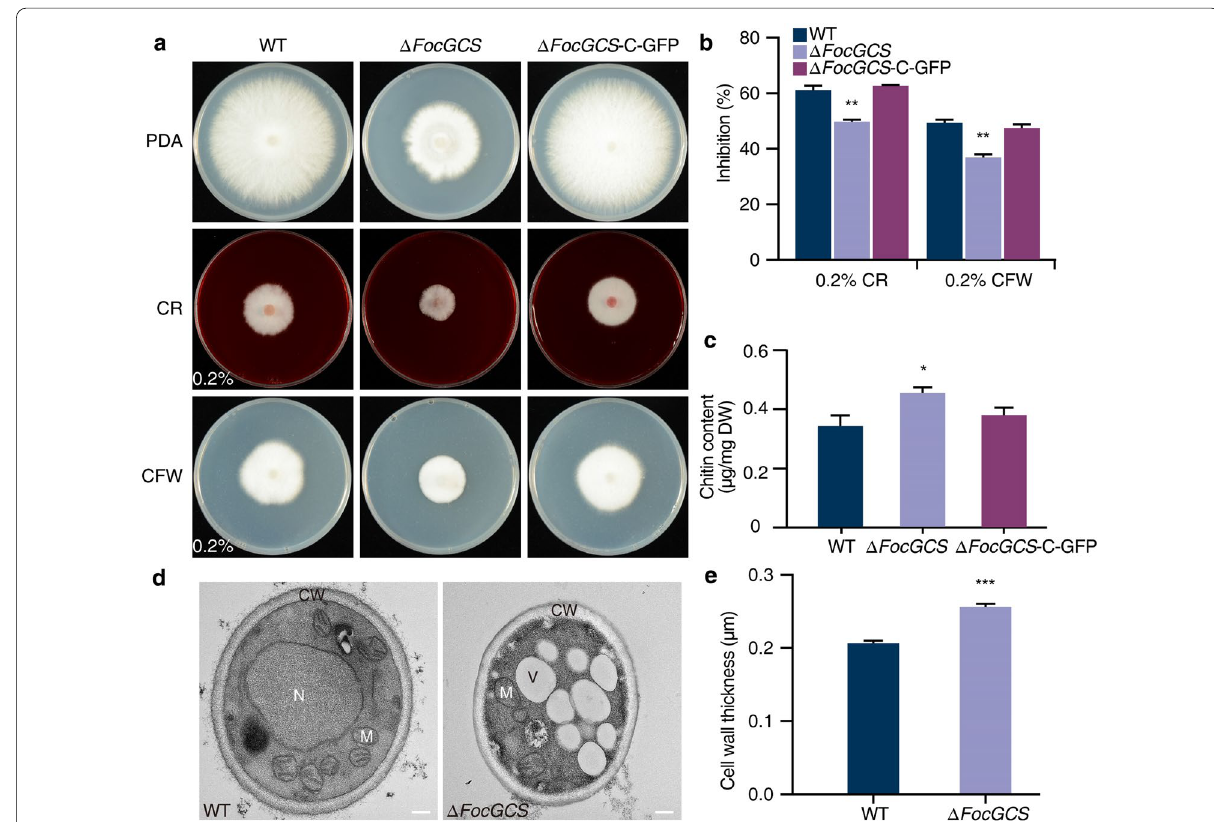
Fig. 6 Cell wall integrity analysis of the WT, ∆ FocGCS , and complemented strains. a Colony morphology of the indicated strains on PDA plates supplemented with 0.2% Calcofluor white (CFW) or 0.2% Congo red (CR). Photos were taken after incubation at 28 °C for 5 days. b The growth inhibition rate based on a . The inhibition rate was calculated by comparing the colony diameter under stress conditions with that under normal conditions. c Cellular chitin levels of the indicated strains measured by colorimetric determination of β‑(1–4)‑linked N ‑acetylglucosamine (GlcNAc). DW, dry weight. d Transmission electron micrographs of the WT and ∆ FocGCS strains. CW, cell wall; M, mitochondrion; N, cell nucleus; V, vacuole. Scale bars 0.2 μm. e Cell wall thickness of the indicated strains measured by 100 spores. The mean values = independent experiments, and asterisks indicate significant differences from the WT group (Student’s t ‑test, * P < 0.05, ** P < 0.01, and *** P <